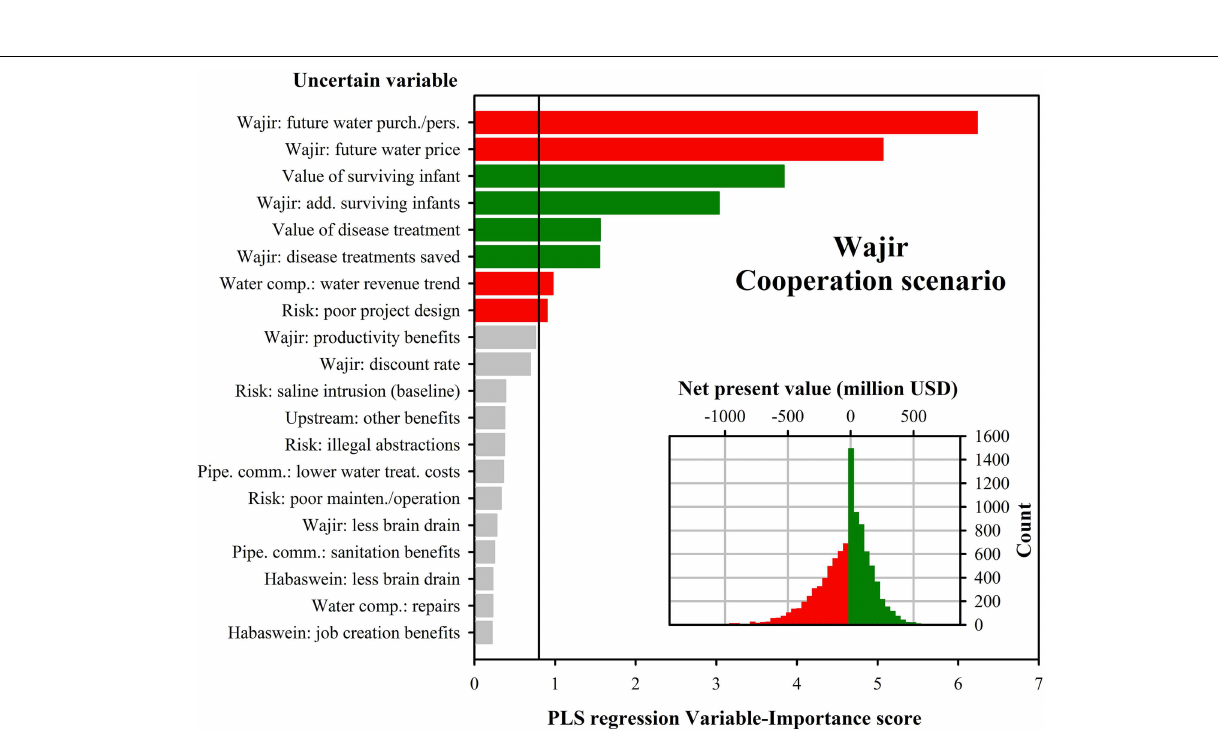
Frontiers in Environmental Science |